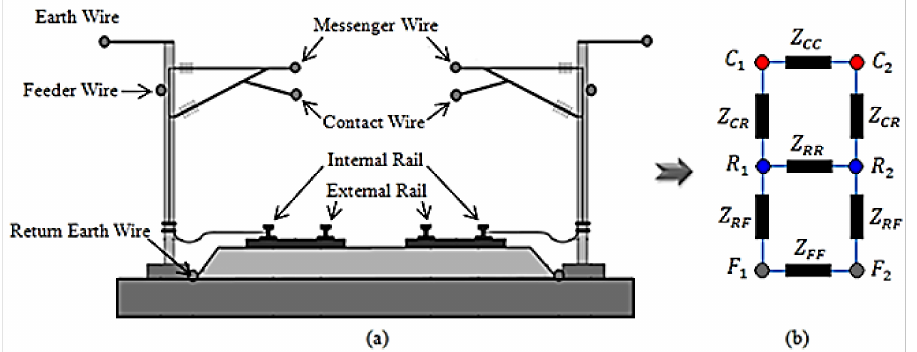
Figure 2. A typical view of MTL system (double lines): ( a ) conductors’ arrangement; ( b ) simplified impedance